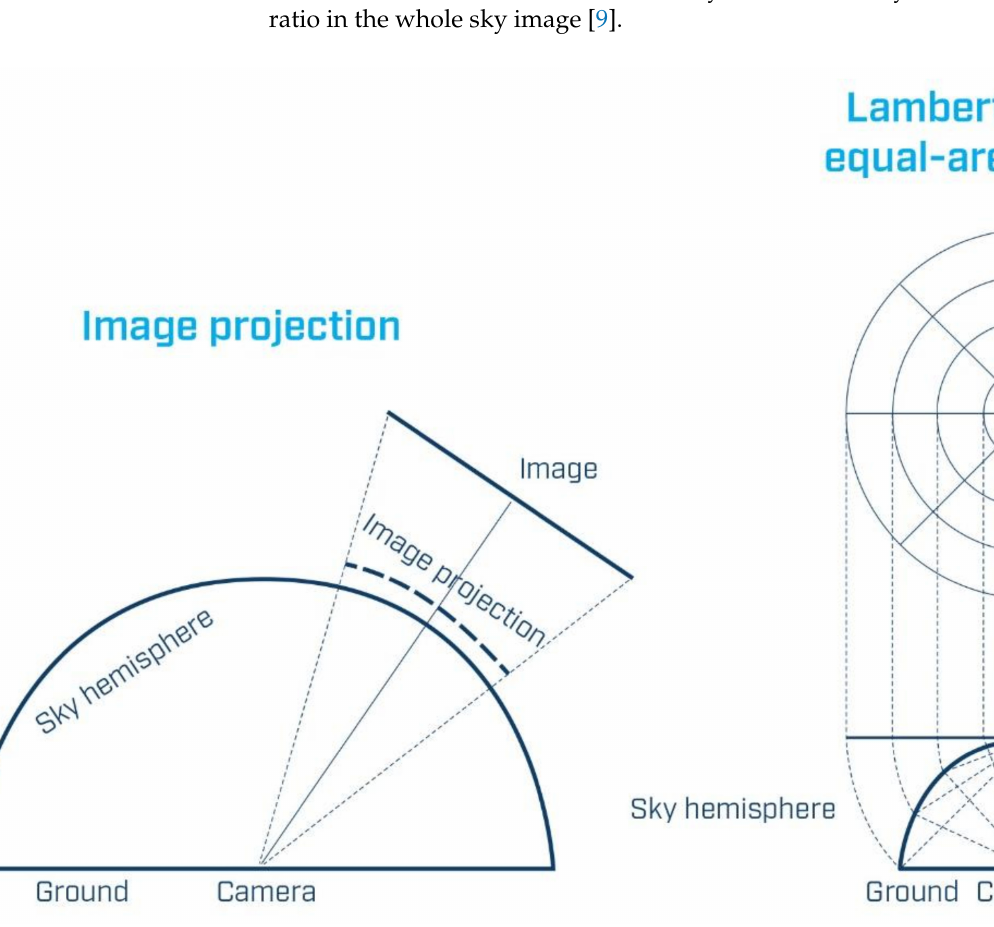
Figure 4. A schematic of the Lambert azimuthal equal-area